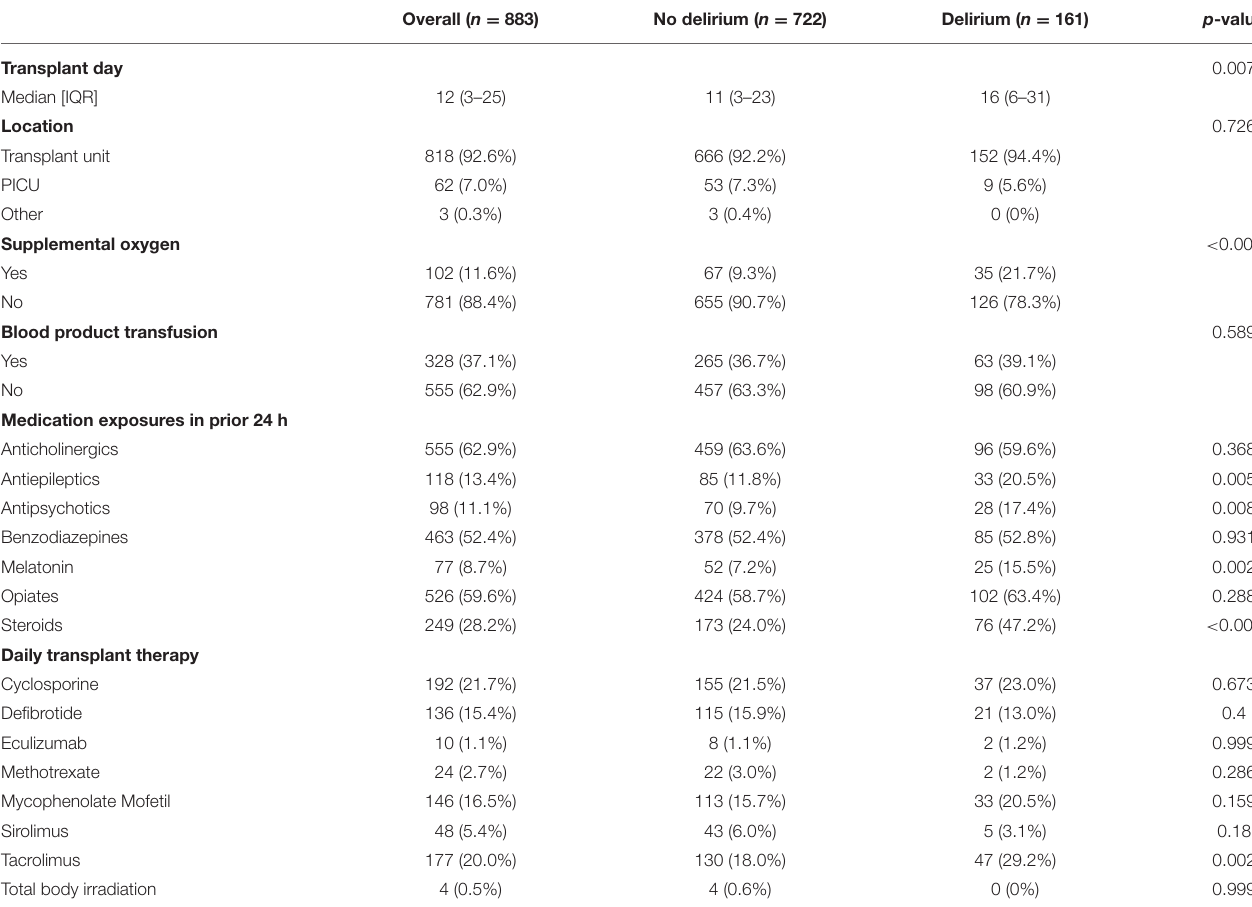
TABLE 2 | Bivariate associations with daily delirium ( n =